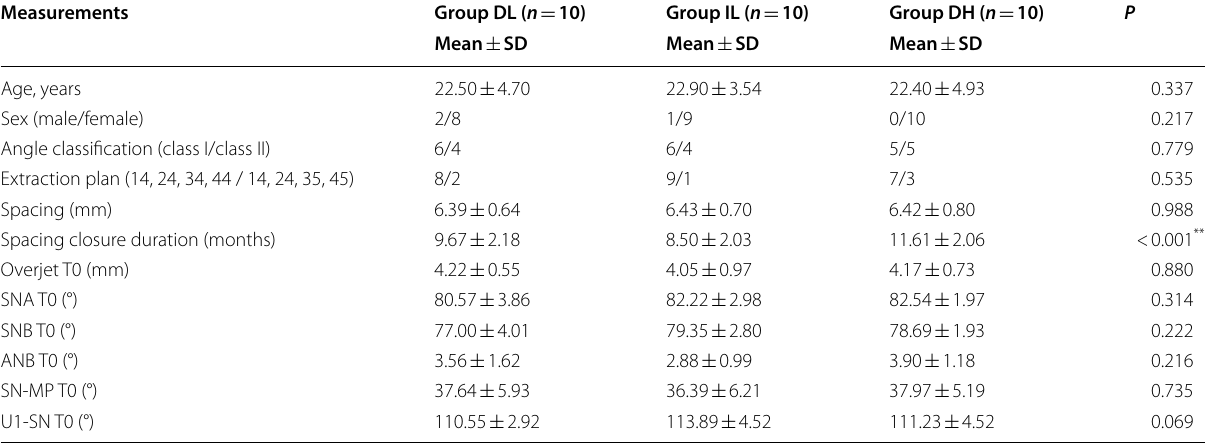
Table 2 Demographic information of including